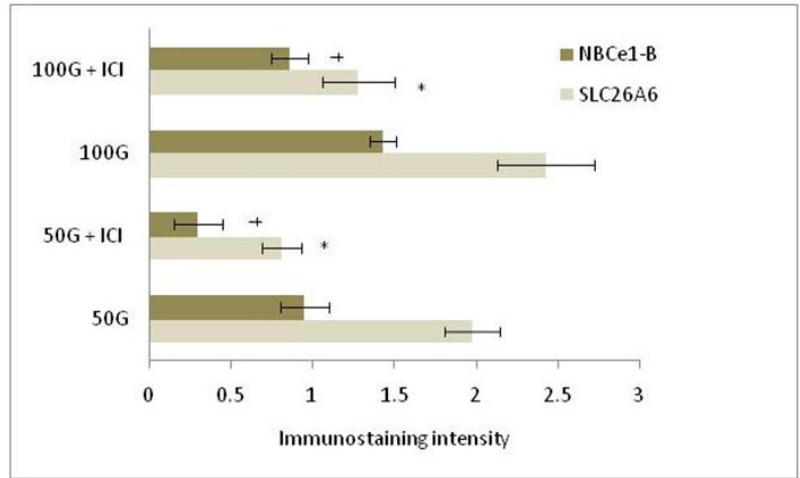
Figure 7. Quantitative analysis of immunostaining intensity of SLC26A6 and NBCe1-B at the apical membrane of the luminal epithelia following treatment with 50 and 100 mg/kg/day genistein by NIS-Element AR program. The intensity for both transporters was the highest at the apical membrane following 100 mg/kg/day genistein treatment.